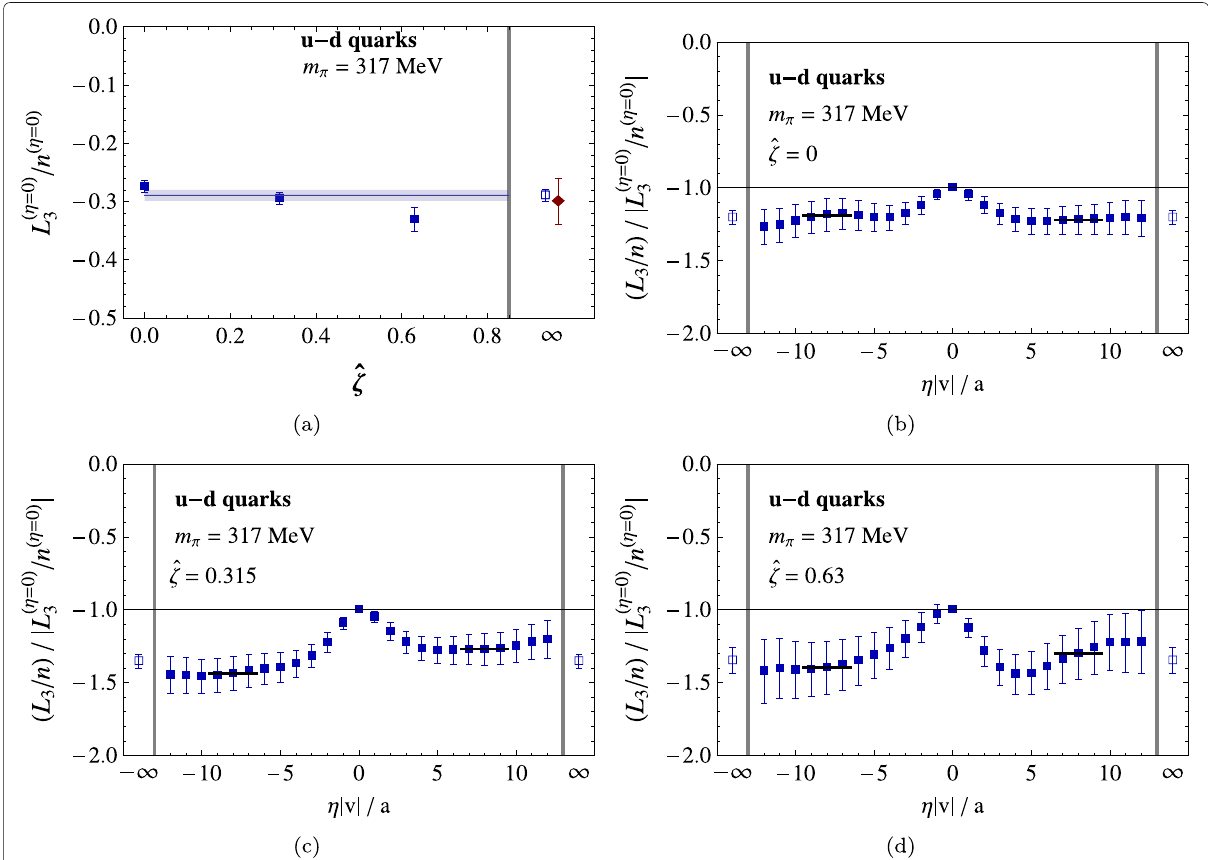
Fig. 2 a Ji quark orbital angular momentum, i.e., the η = 0 limit, for the three values of ˆ ζ probed, with the average plotted at ˆ ζ = ∞ (open square). The filled diamond represents the value extracted at the same pion mass in the MS scheme at the scale μ 2 = 4GeV 2 via Ji’s sum rule in Eq. (2). The isovector u − d quark combination was evaluated. The shown uncertainties are statistical jackknife errors. b Quark orbital angular momentum at ˆ ζ = 0 as a function of staple length parameter η | v | / a , normalized to the magnitude of Ji quark orbital angular momentum, i.e., the result obtained at η = 0.Theisovector u − d quarkcombinationisshownwiththestatisticaljackknifeerrors. c Thesameas b for ˆ ζ = 0.315. d Thesameas b for ˆ ζ = 0.63